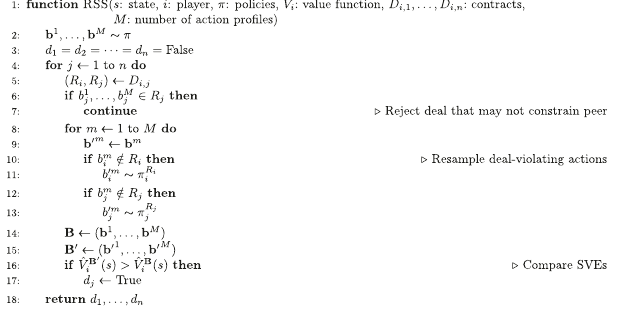
Algorithm 2 Restriction Simulation